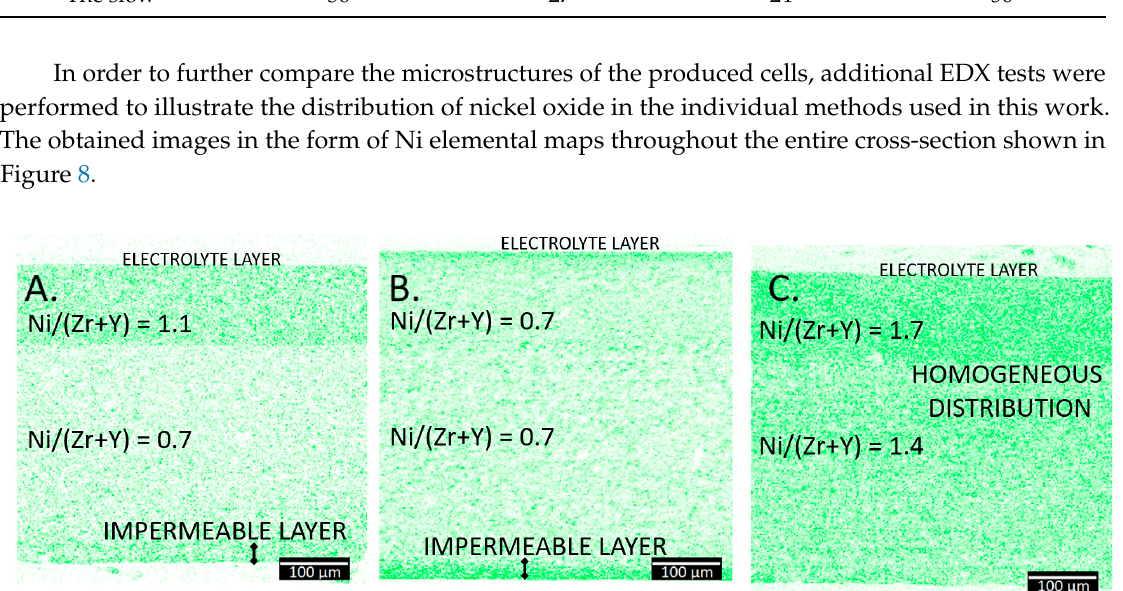
Figure 8. Nickel elemental maps (based on EDX analyses) of samples with ( A ) 34 vol.% NiO obtained using the “standard” method, ( B ) 30 vol.% NiO obtained using the “fast” method ( C ). 36 vol.% NiO obtained using the “slow” method. Dense electrolyte is in the top part of the images, followed by the functional layer and the porous support.